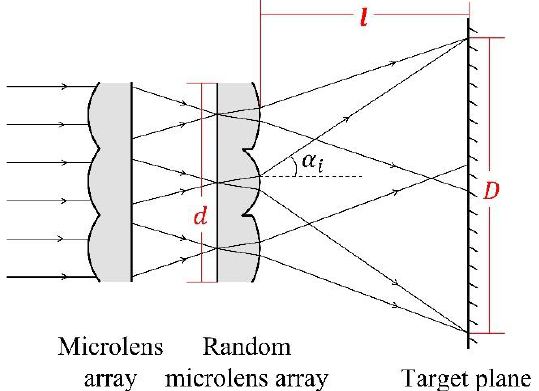
Figure 5. The schematic diagram of light uniform mixing. The collimated beam from the TIR lens is split into many parts by the microlens array, and each part is modulated by the random microlens array into beams with different divergence angles α i . Rays with divergence angles are sufficiently mixed in space, and different areas of colored illumination are formed in the target plane. These colored illumination areas are completely overlapped on the target plane by limiting the range of angles α i . The range of angle variation is limited by Equation